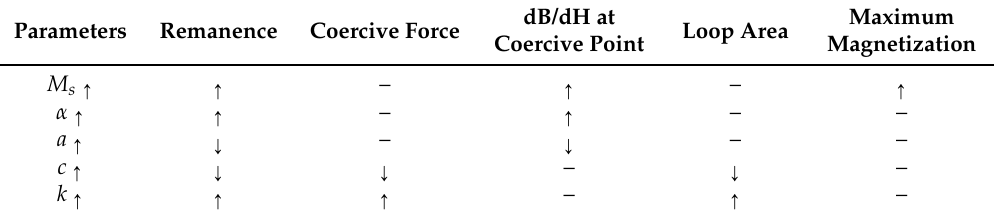
Table 1. Influence of the parameters to the hysteresis